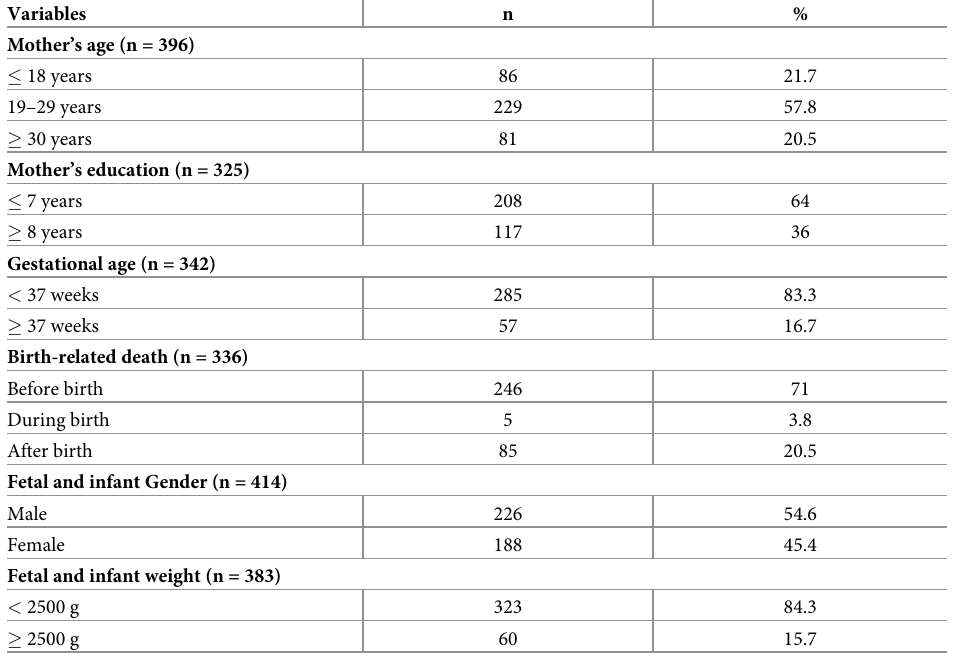
Table 1. Analysis of the variables related to the mother, the birth and the fetal and infant deaths. Ceara´, Brazil, 2010–2014.